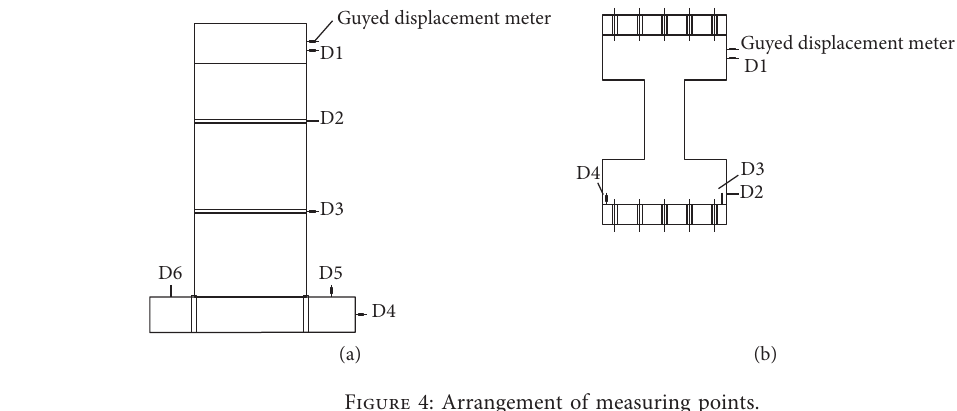
Figure 4: Arrangement of measuring points.